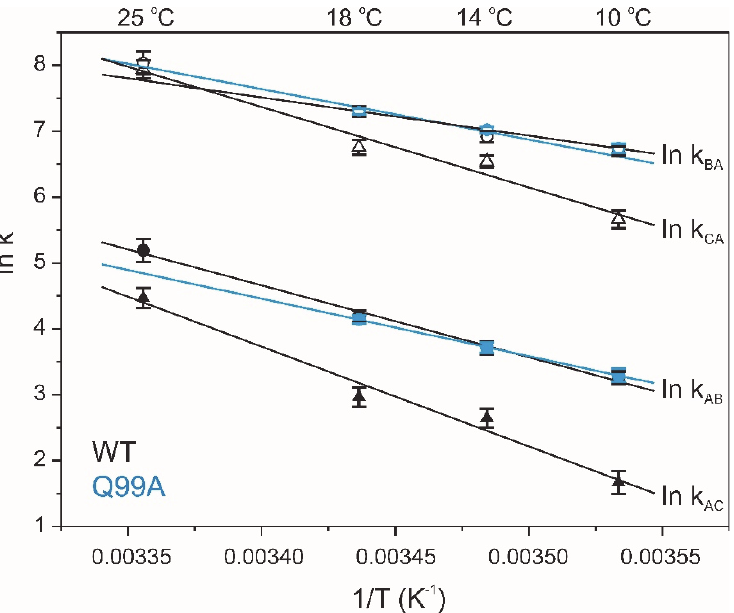
Figure 8. Temperature dependence of conformational exchange in wild ‐ type (black) and Q99A (cyan) apo human I ‐ BABP. Forward (closed) and reverse (open) rate constants of the conformational exchange obtained from global two ‐ state analysis of relaxation dispersion curves. The slower cluster (triangles) is observed only in the wild ‐ type form.